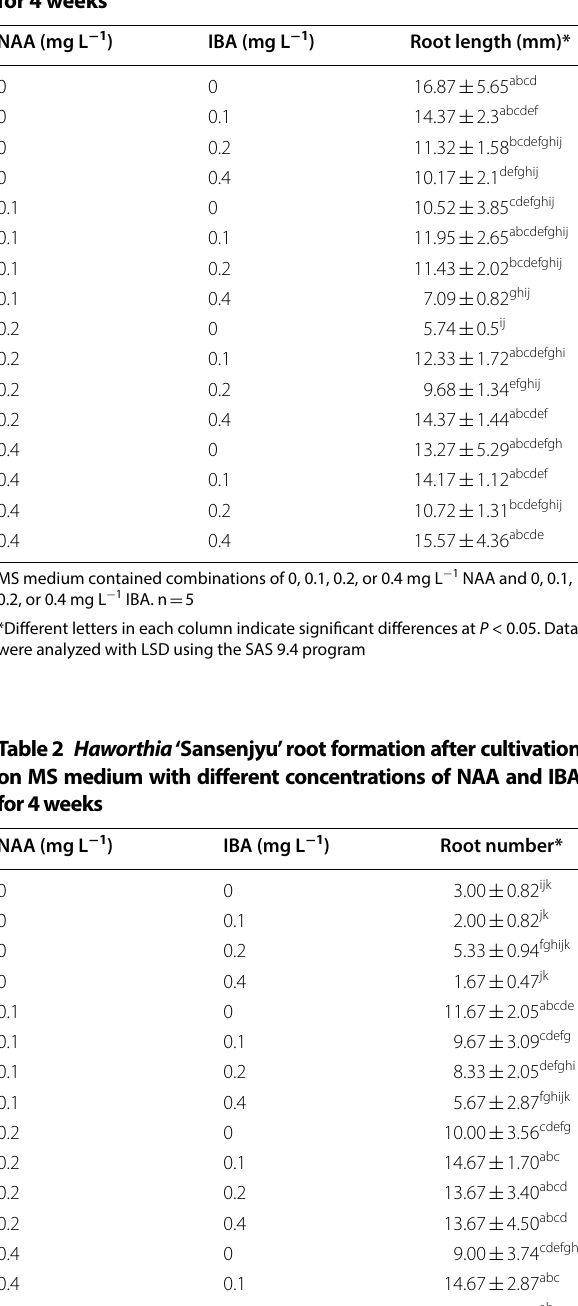
Table 1 Haworthia ‘Sansenjyu’ root length after cultivation in MS medium with different concentrations of NAA and IBA